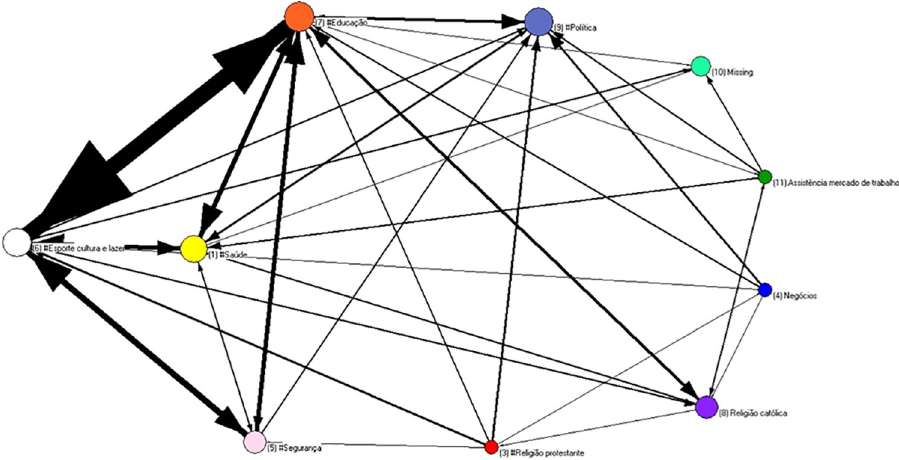
Fig 1. Alpha community strength of ties by